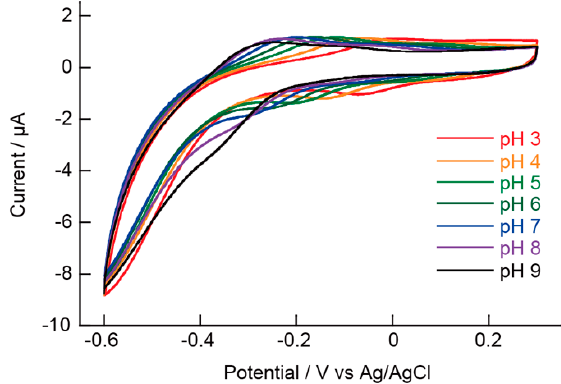
Figure 4. Voltammograms of cyclic voltammetry (CV) measurements in phosphate buffer solution (100 mM) at pH = 3 to 9 using the (PAH/AA-PMA) 5 -modified electrode.